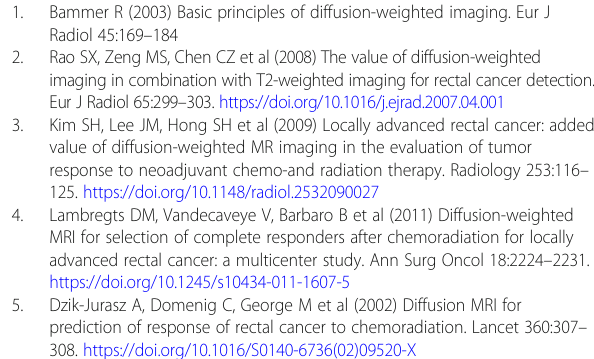
Additional file 1: Figure S1. Score distributions for all evaluation aspects. Figure S2. Tumor ROIs from the first delineation of 29 cases used for the DSC calculation. DSC calculation is illustrated in Fig. 1. DSC values derived from two ROI delineations had excellent agreement (ICC =